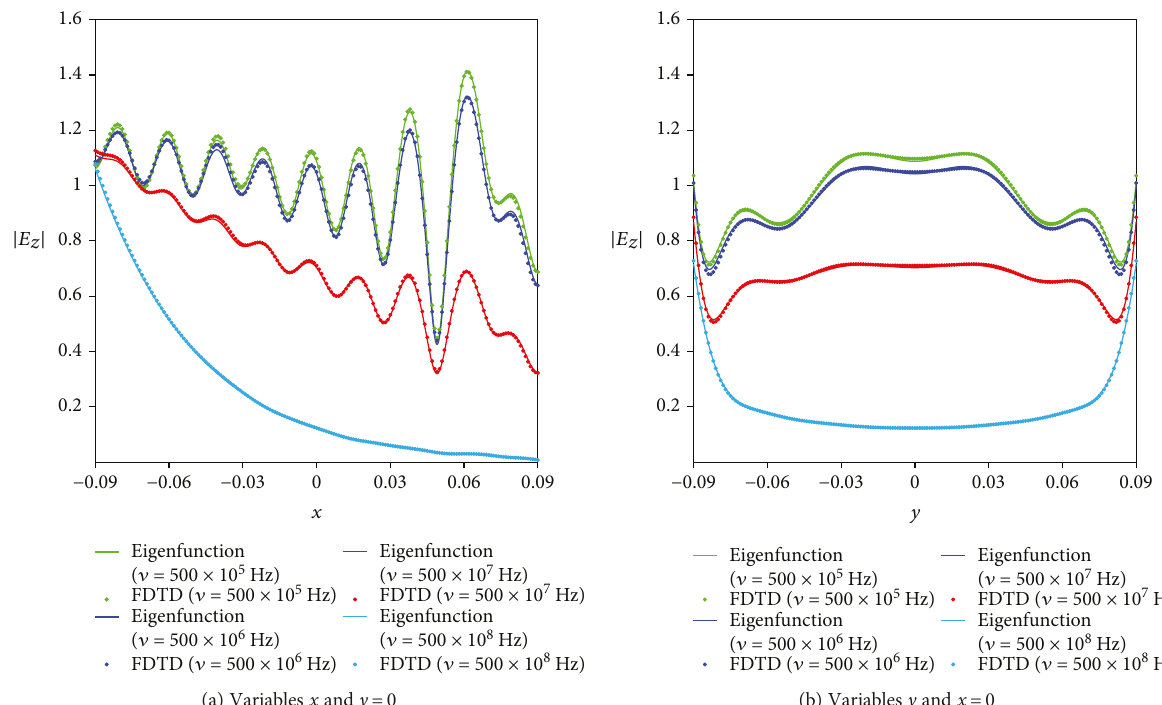
Figure 11: Comparison between the magnitude of the electric fi eld, in volts/meter, inside the plasma for linear cuts through the cylinder obtained by the eigenfunction method and the FDTD simulation for di ff erent collision frequencies; incident wave frequency is set to f =10 GHz, and electron density is set to n =5 × 10 17 m − 3 in 0